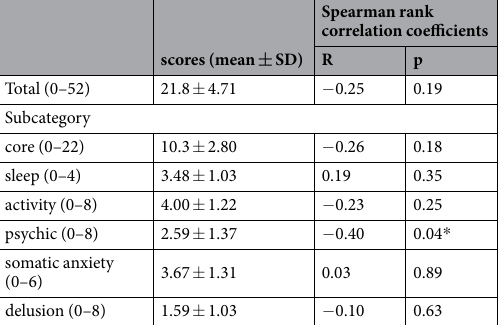
Table 3. Relationship between the scores of Hamilton Depression Rating Scale (HAM-D) and GM volume of the left insula lobe. * p < 0.05. Ranges of each subcategory score are reported in parentheses.